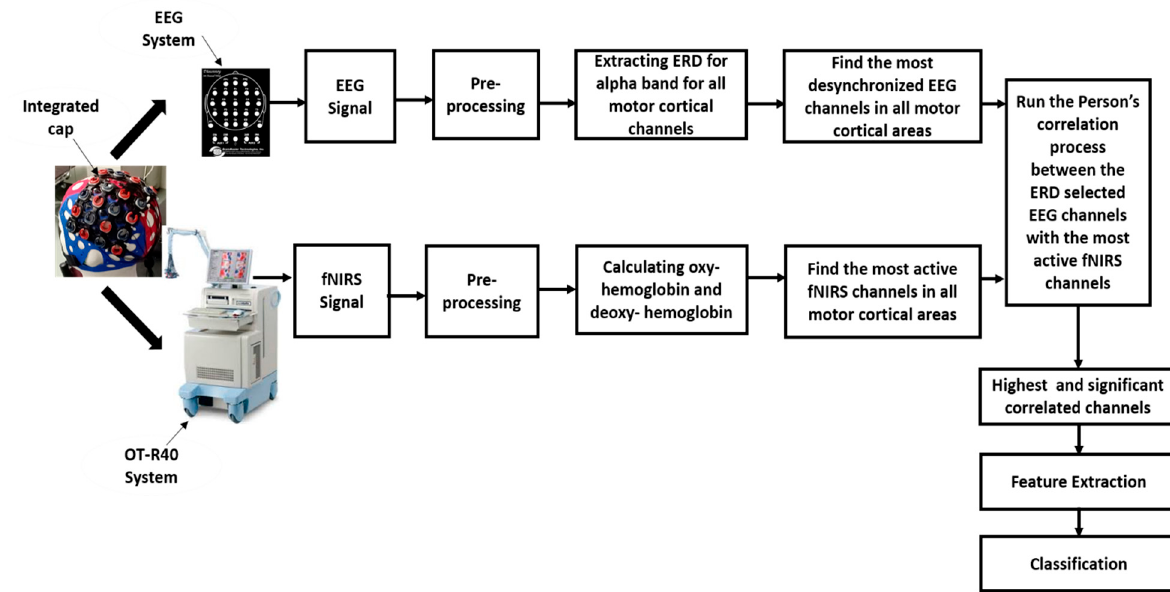
Figure 1. The proposed framework of functional near-infrared spectroscopy (fNIRS)–electroencephalography (EEG) simultaneous measurements and analysis during lower limb movements. ERD, event-related desynchronization.